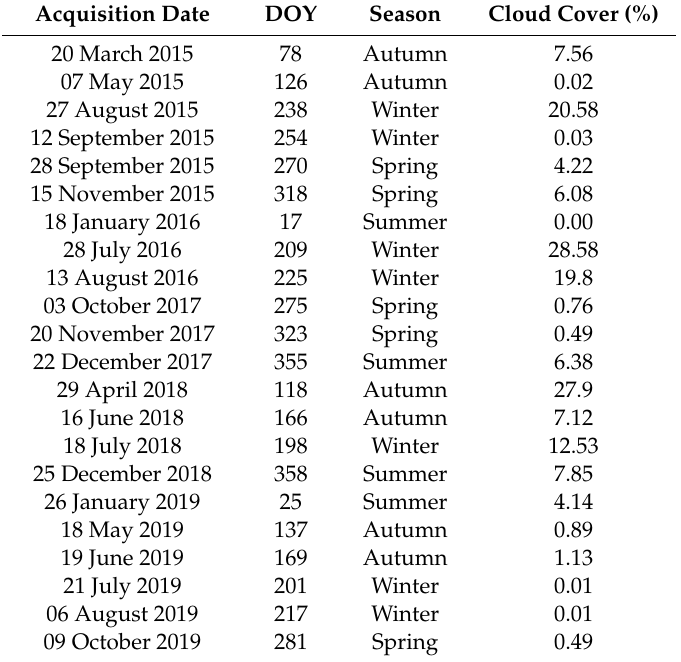
Table 2. Information of the Landsat 8 OLI / TIRS scenes used in this study, Path / Row (222 /